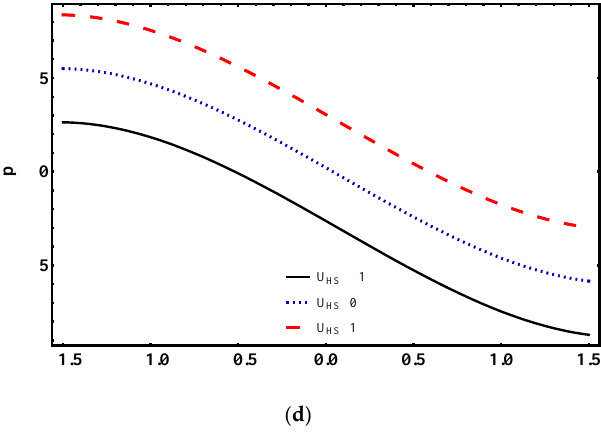
Figure 3. Pressure rise ∆ P λ profile for ( a ) W e ; ( b ) n i ; ( c ) m e ; ( d ) U HS .